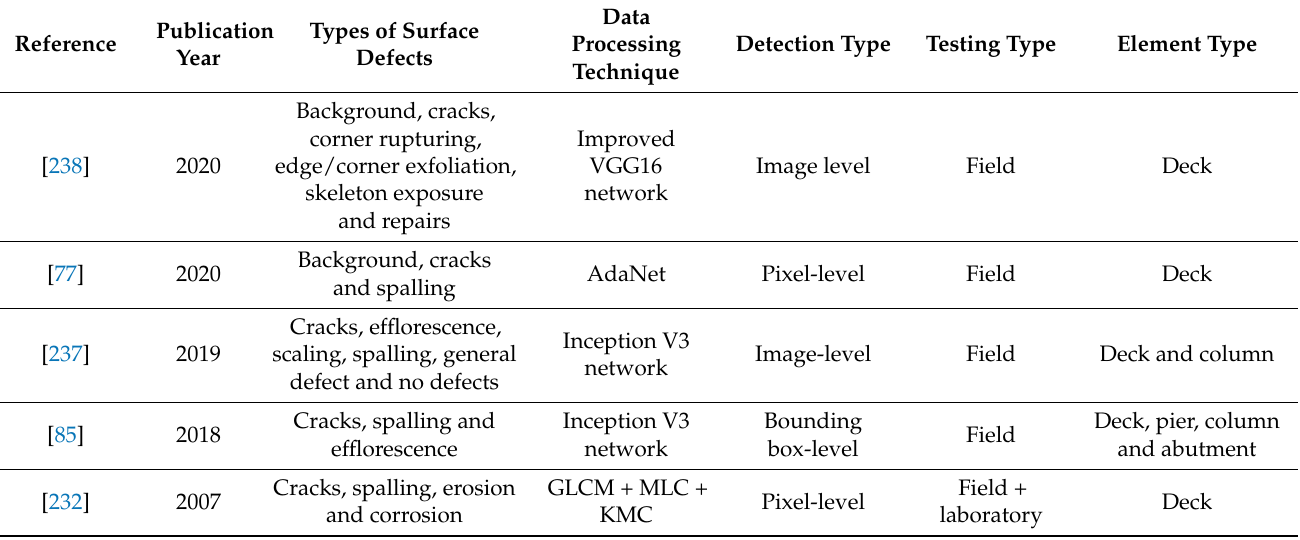
Table 20. Summary of some of the research studies on the classification of bridge surface defects (Cont’d).